Question: Briefly state, in one sentence, what is plotted here.
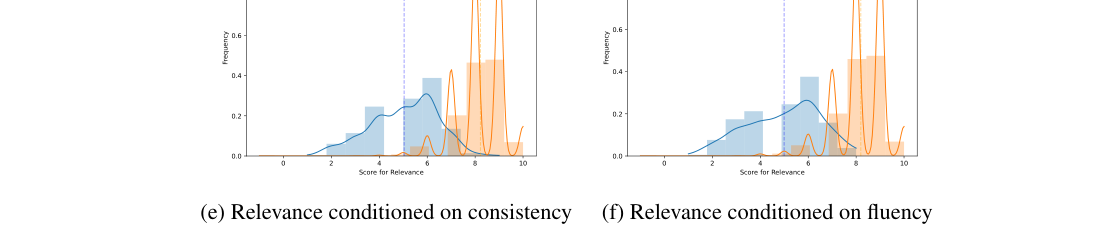
Answer: Distribution of scores conditioned on the values of previous scores in the same generation.